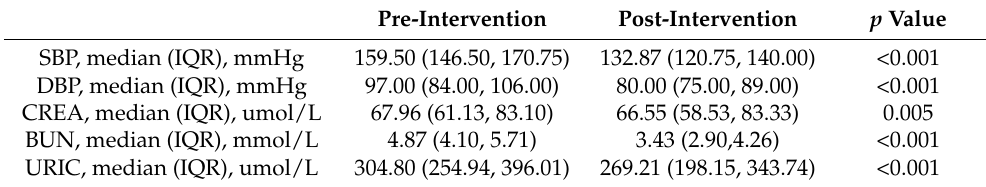
Table 3. Blood pressure condition, renal function index of FMD patients before and after intervention. Pre-Intervention Post-Intervention p